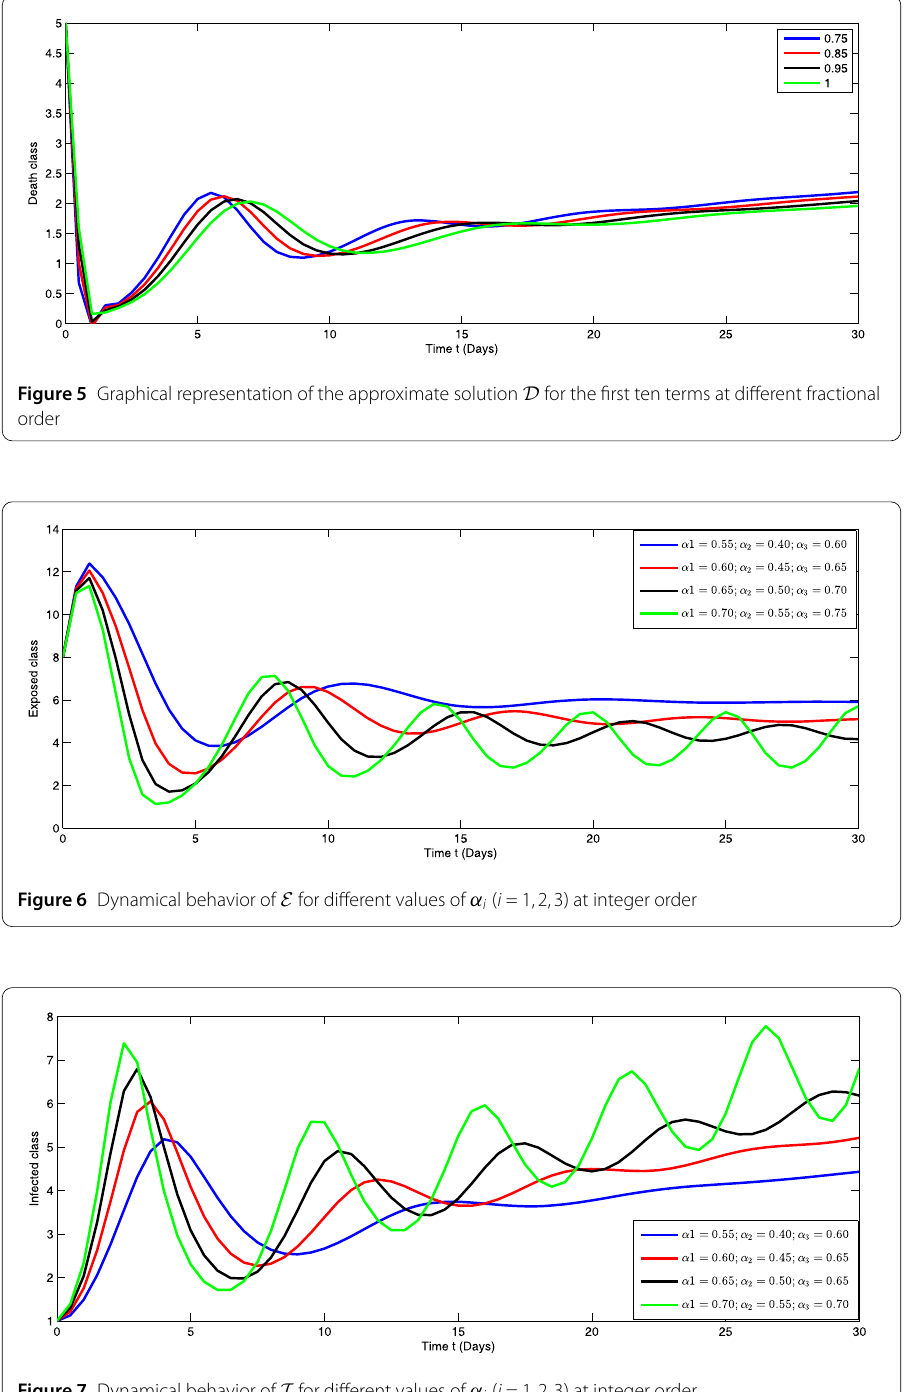
( i = 1,2,3), the corresponding infection, hospitalization and chronic infection are increas- ing. Also the uncertain behavior has been observed on increasing the corresponding val- ues of the aforesaid three parameters. Here we use a nonstandard finite difference scheme for the illustration of the dynamics at given values of the